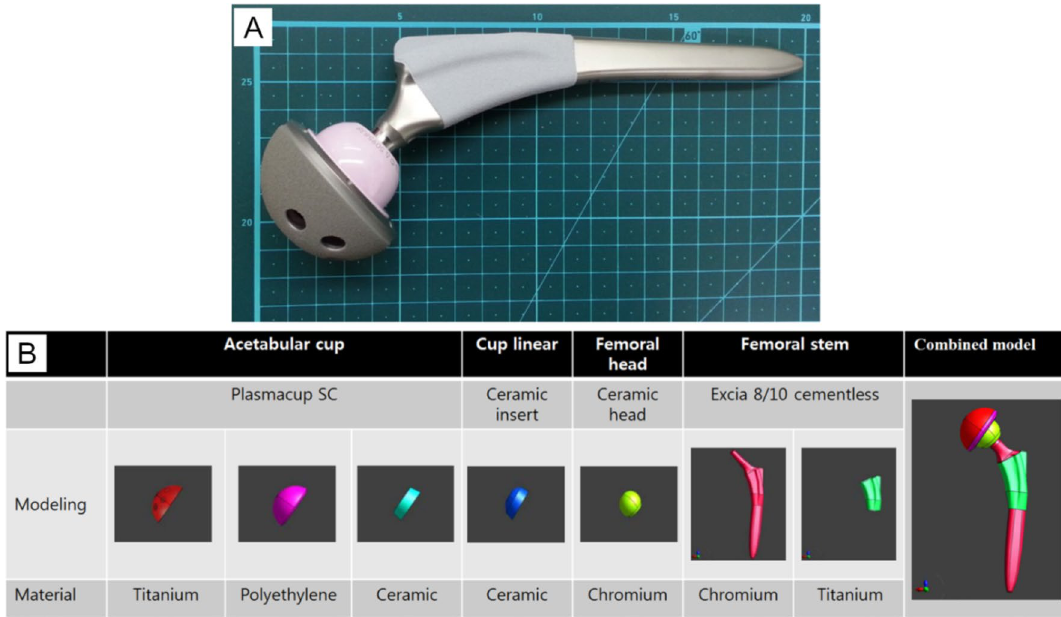
Figure 4. An artificial hip joint ( A ) and modeling for the artificial hip joint ( B ) using AutoCAD 2015 software (Autodesk, San Rafael, USA. https ://www.autod esk.com/). The head and tail of the implant are connected electronically.